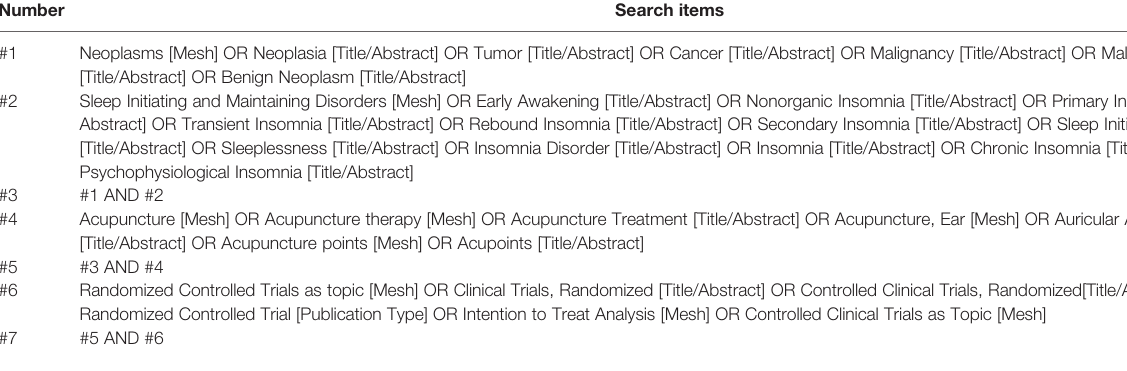
TABLE 1 | Search strategy used for the PubMed